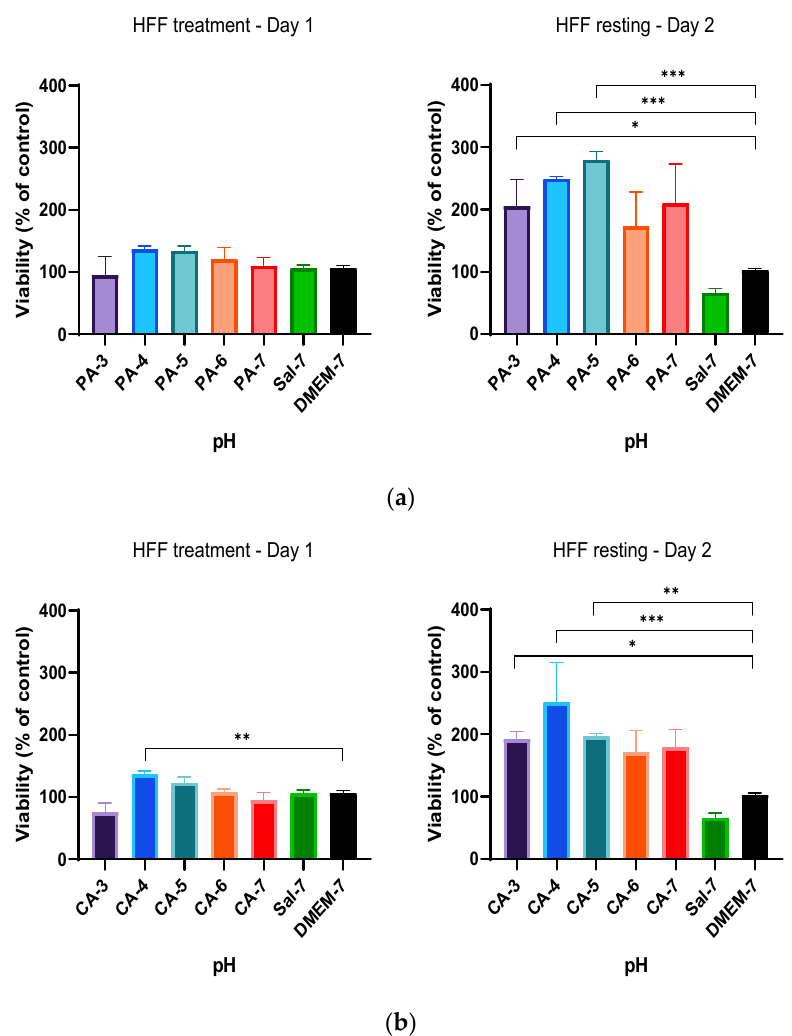
Figure 6 . The effect of acidic pH buffers on the metabolism rate of HFF fibroblast cells. HFF cells were cultured in DMEM growth media with the treatment of acidic buffers for a duration of 24 h, followed by aspiration and replacement of fresh DMEM media for another 24 h. ( a ) Percentage viability of HFF cells when treated with 0.01 M phosphoric acid (PA), with pH adjusted to 3, 4, 5, 6 and 7 and ( b ) treatment with 0.01 M citric acid (CA) buffer solutions (pH 3 to pH 7). The results are expressed as mean ± standard deviation. Statistical significance (* p < 0.05, ** p < 0.01 and ***p < 0.001) when compared with the percentage viability of HFF cells in the control group (DMEM-7).